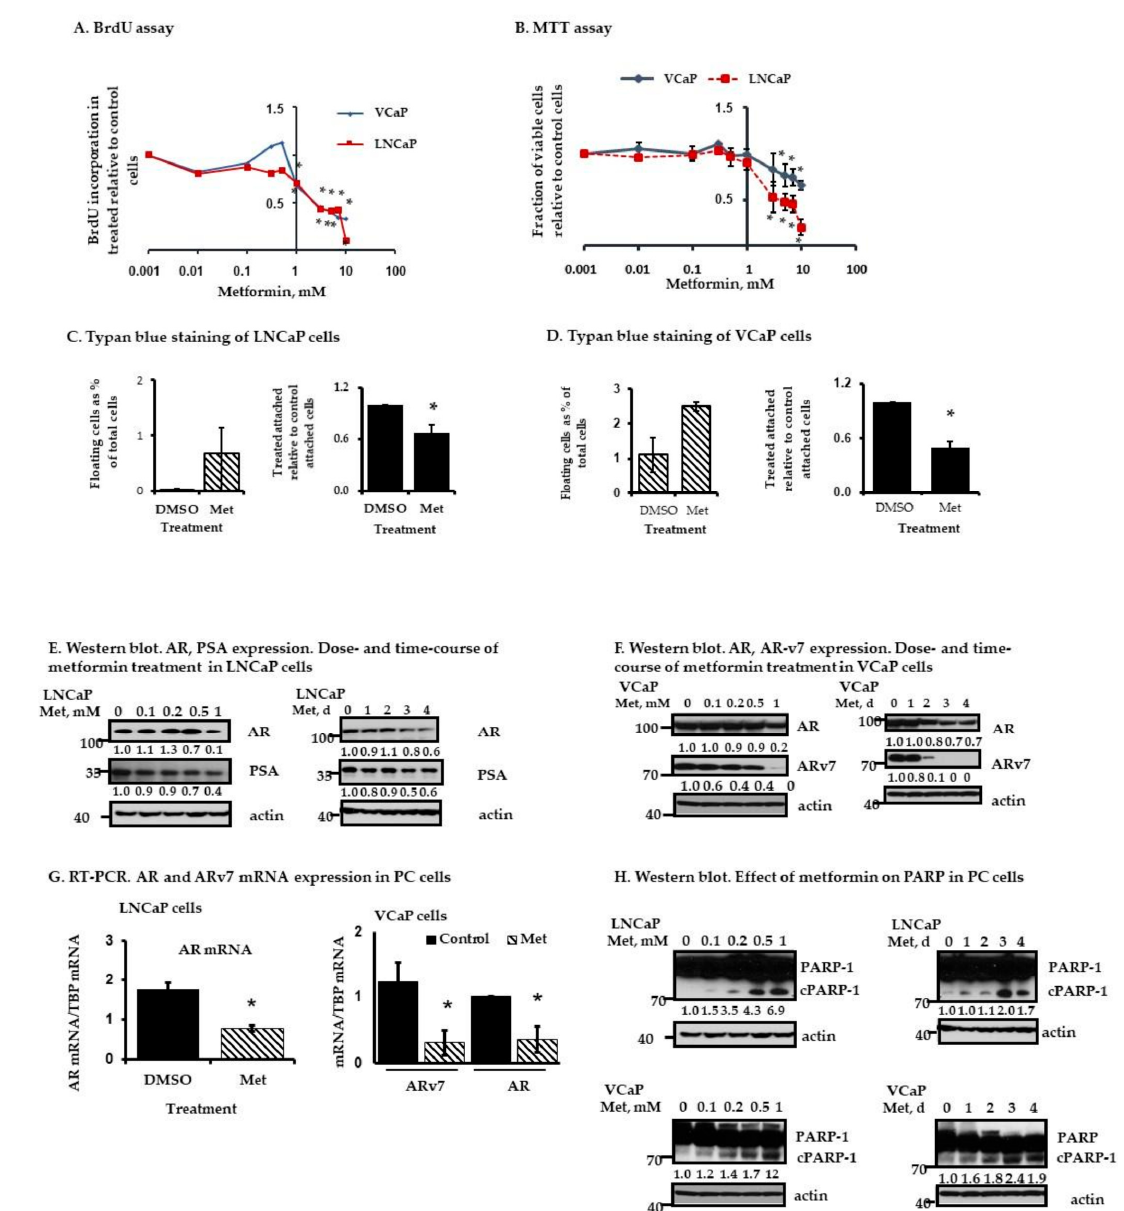
Figure 2. Effect of metformin on LNCaP and VCaP cells. ( A ) BrdU assay. Effect of metformin dose on cell proliferation. Shown is BrdU incorporation in 3 days metformin-treated cells as a fraction of control (DMSO-treated) cells. Results represent the mean ± S.D. from three separate experiments, each done with triplicate determinations per data point. (* p < 0.05), Student’s t -test. ( B ) MTT assay. Cells were treated with increasing doses of metformin for 3 days. Shown are the fractions of viable treated cells relative to control (DMSO-treated) cells. Results represent the mean ± S.D. from three separate experiments, each done with triplicate determinations per data point. (* p < 0.05), student’s t -test. ( C , D ) Trypan blue staining. Cells were treated with metformin 1 µ M or DMSO (control) for 5 days and stained with trypan blue. Both floating and attached cells were collected. ( C ) Left. LNCaP floating cells shown as a percentage of total treated cells (floating + attached) within each plate. Right. Metformin-treated LNCaP attached cells are shown as a fraction of attached control (DMSO-treated) cells (set as 1). ( D ) Left. VCaP floating cells shown as a percentage of total treated cells (floating + attached) within each plate. Right. Metformin-treated VCaP attached cells are shown as a fraction of attached control (DMSO-treated) cells (set as 1). Results represent the mean ± S.D. from two separate experiments, each done with triplicate determinations per data point. (* p < 0.05), Student’s t -test. ( E ) Western blot. AR, PSA expression in metformin-treated LNCaP cells. Left, dose course (cells were treated with increasing concentrations of metformin for 4 days). Right, time course (cells were treated with metformin 1 mM for a different number of days). ( F ) Western blot. Same as in ( E ), metformin treated dose-course and time-course in VCaP cells. Westerns are representative of two independent blots. ( G )